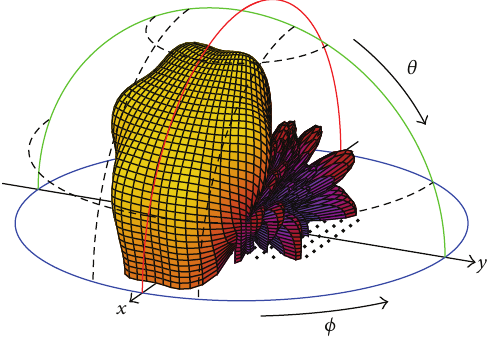
Figure 15: Coverage after steering the SHA-169 𝑆 𝑓 pattern to (0 ∘ , 35 ∘ ) .